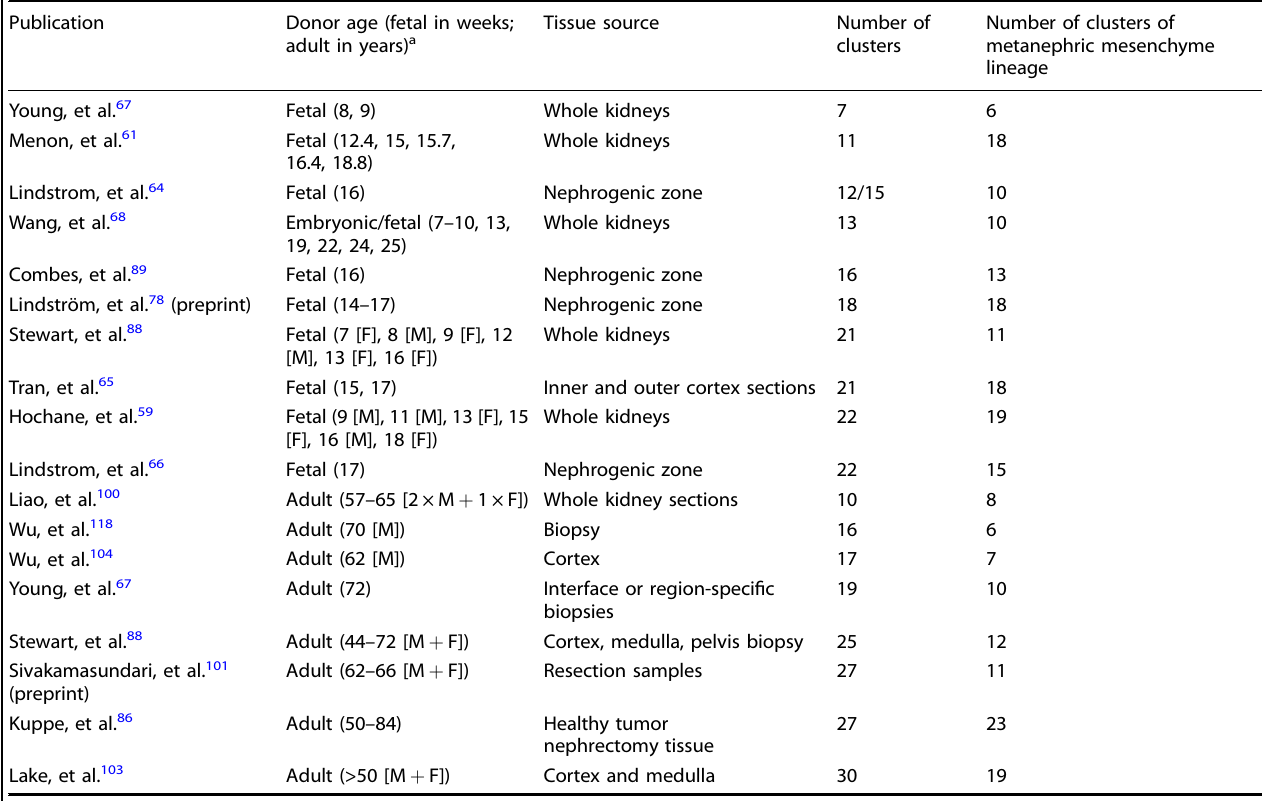
Table 1. Donor information and detected cell clusters from single-cell RNA sequencing studies of healthy human kidney